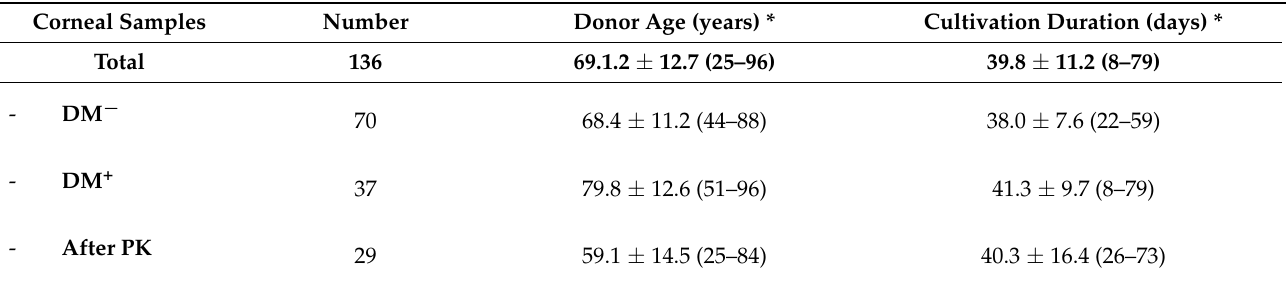
Table 1. Organ-cultured corneal sample